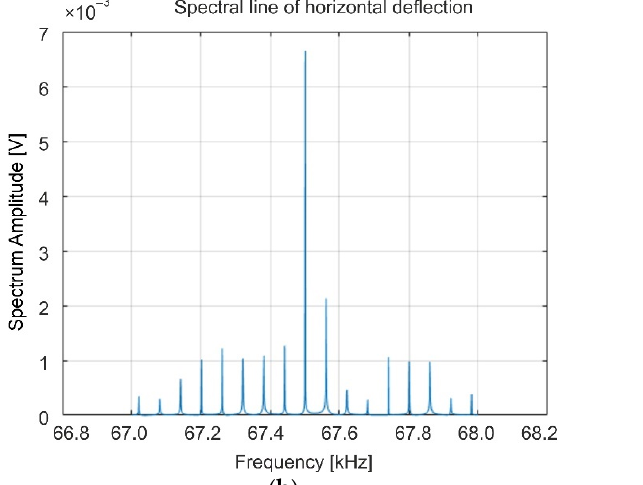
Figure 4. ( a ) Amplitude spectrum of the test signal (window of MS Word editor) and magnification of its fragments corresponding to the ( b ) horizontal and ( c ) vertical sync frequencies.